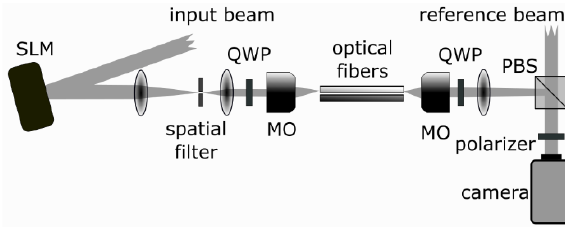
Fig. 1 : Experimental apparatus with spatial light modulator (SLM), quarter waveplates (QWP) and microscope objectives